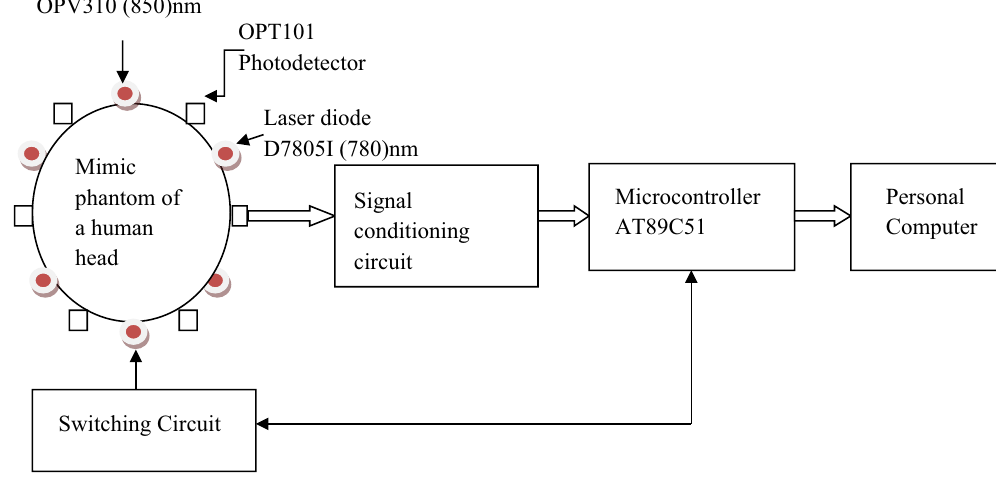
Figure 1. Diffuse optical tomography experimental model.